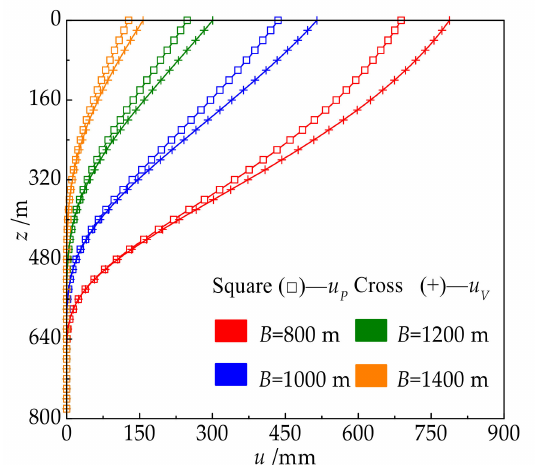
Figure 8. The shaft horizontal displacement curve ( n = 4).